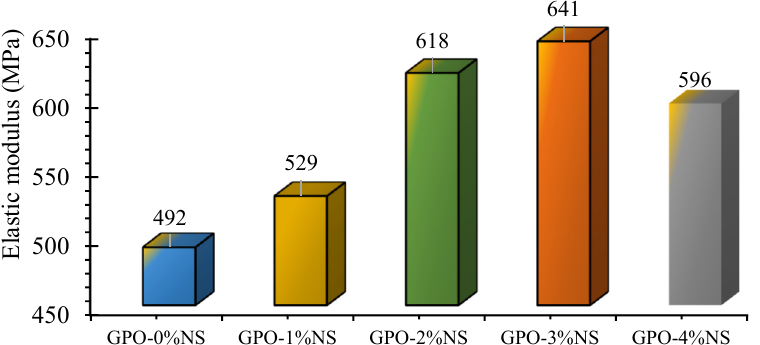
Figure 7. Elastic moduli of carbon-fiber-reinforced GPO composite pastes with various contents of NS.